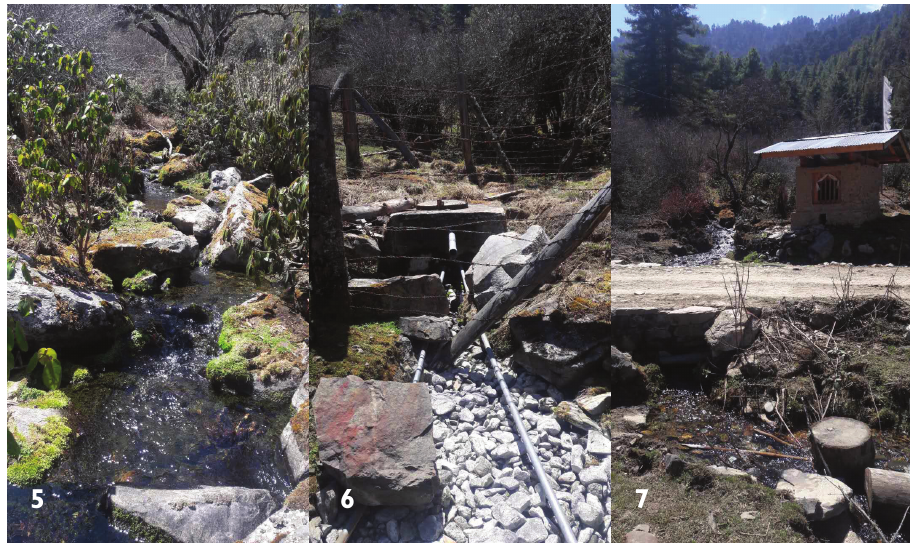
Figure 4. Maximum likelihood tree based on the 16S rRNA dataset of Liu et al. (2014). Numbers on branches denote bootstrap values